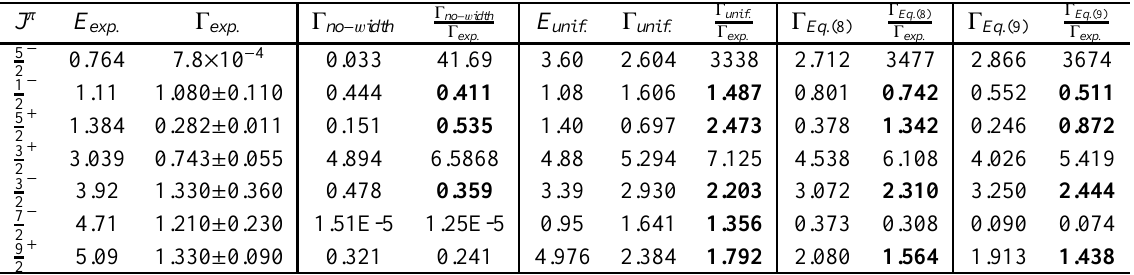
Table 1. Experimental 9 Be states’ J π , centroids and widths [15]; theoretical widths and ratios to experiment for the case with no target-state widths; theoretical centroids, widths and ratios to experiment for the case with uniform target-state widths; theoretical widths and ratios to experiment for the case where target-state widths vary with Eq. (9); and theoretical widths and ratios to experiment for the case where target-state widths vary with Eq.